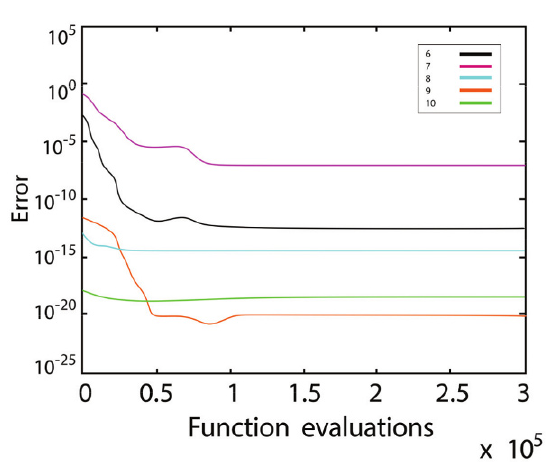
Figure 11. The results of applying the MSCA on F 6 – F 10 (Conver- gence of Functions F 6 – F 10 ).